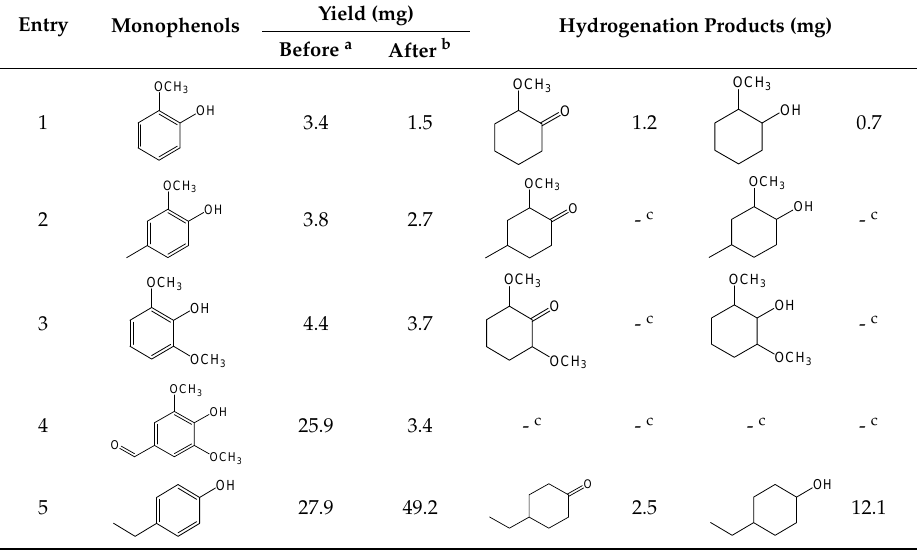
Table 4. The yield of monophenols before and after the catalytic hydrogenation of lignin-derived liquid mixture.